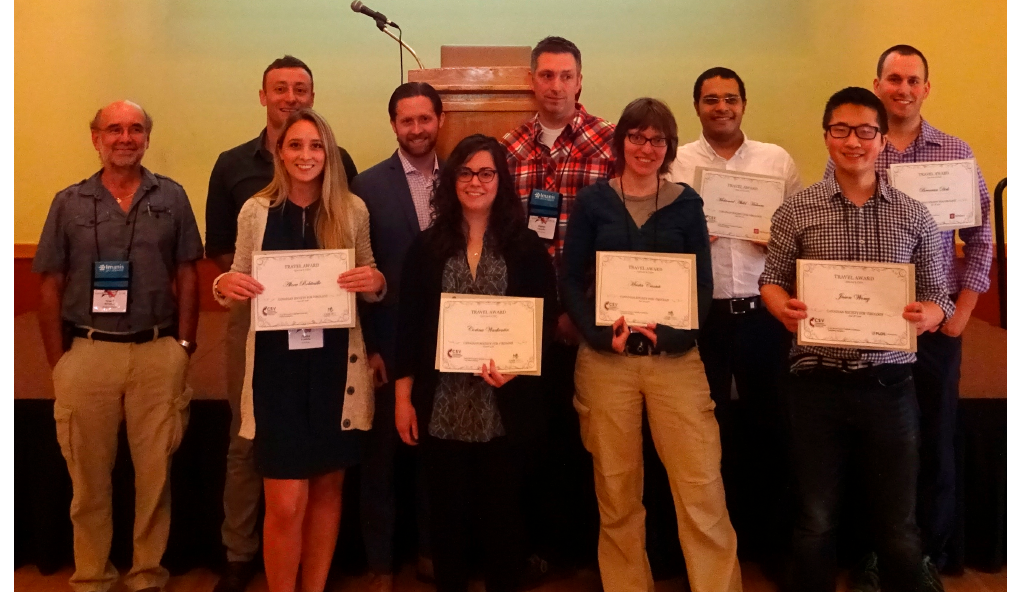
Figure 2. Presentation of travel awards to trainee presenters at the 1st Workshop of the Canadian Society for Virology (CSV2016). Each trainee abstract selected for an oral presentation by an